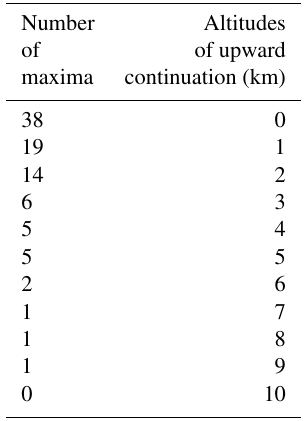
Table 2. Maxima and altitudes of upward